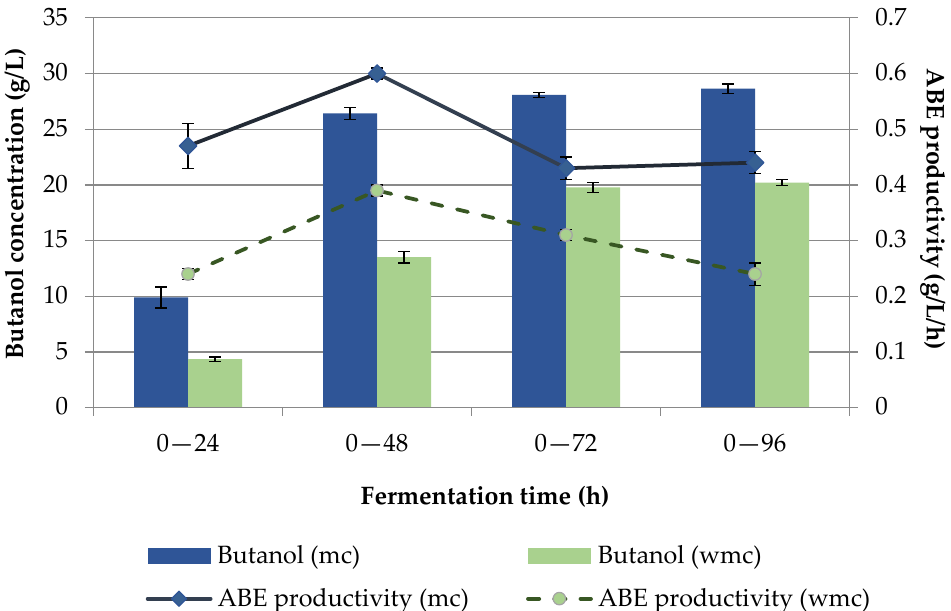
Figure 2. Butanol production and ABE productivity through consolidation SHF and SSF (simulta- neous saccharification and fermentation) processes (SHF/SSF mc — with mineral compounds; SHF/SSF wmc — without mineral compounds).